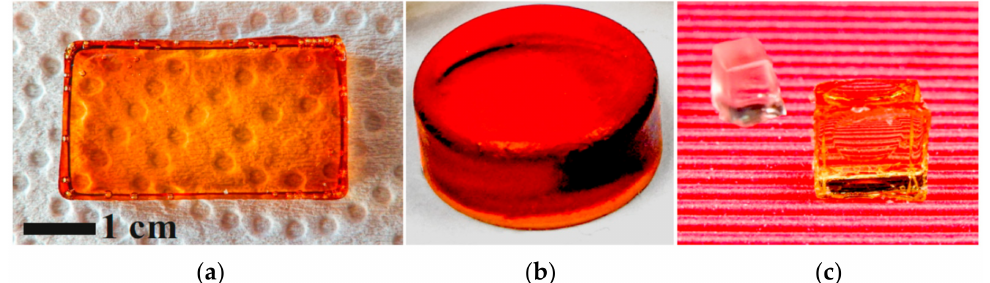
Figure 2. Pictures of samples of the TA@SiO 2 bionanocomposite synthesized in solutions with TA, in the form of a plate 8 mm thick ( a ), a disk ( b ), and cubes ( c ). Picture ( c ) on the left shows a SiO 2 sample after washing off the